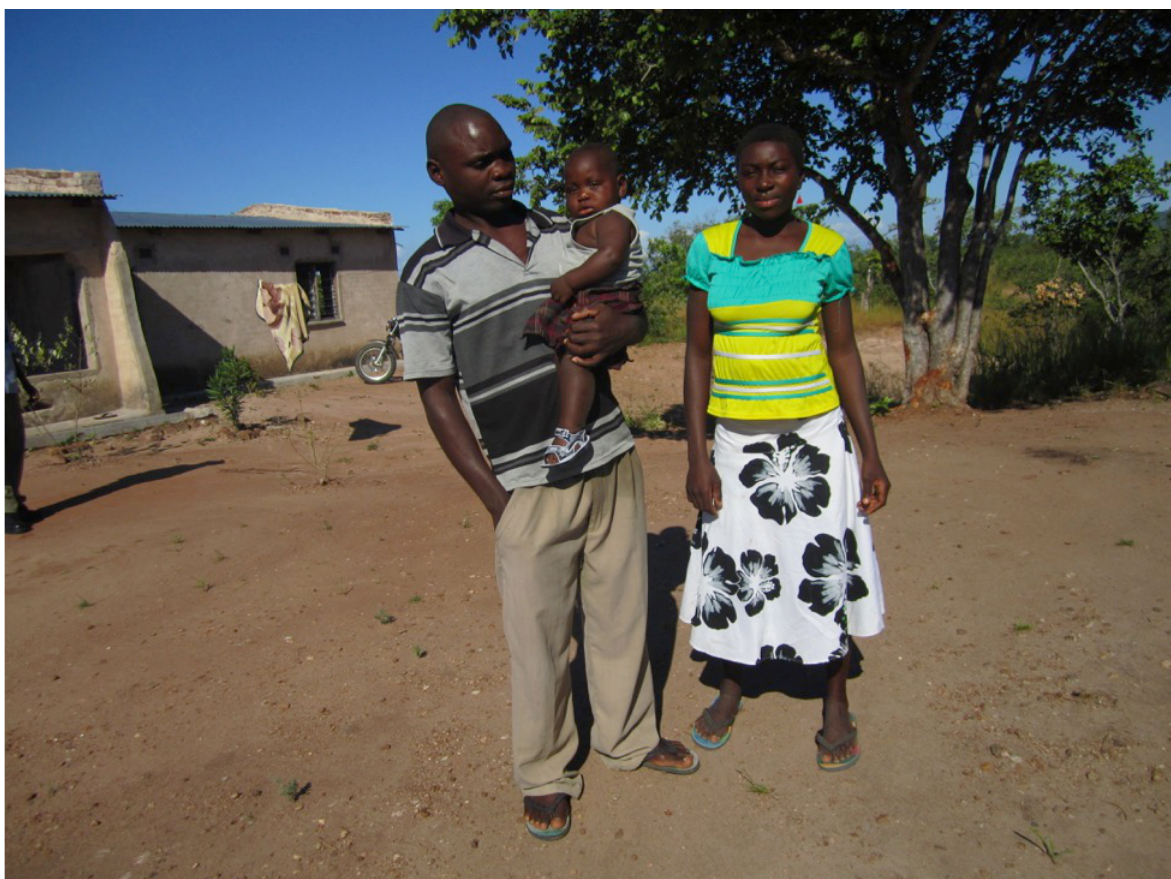
Photograph 5: Farmer (28) with his wife and their first